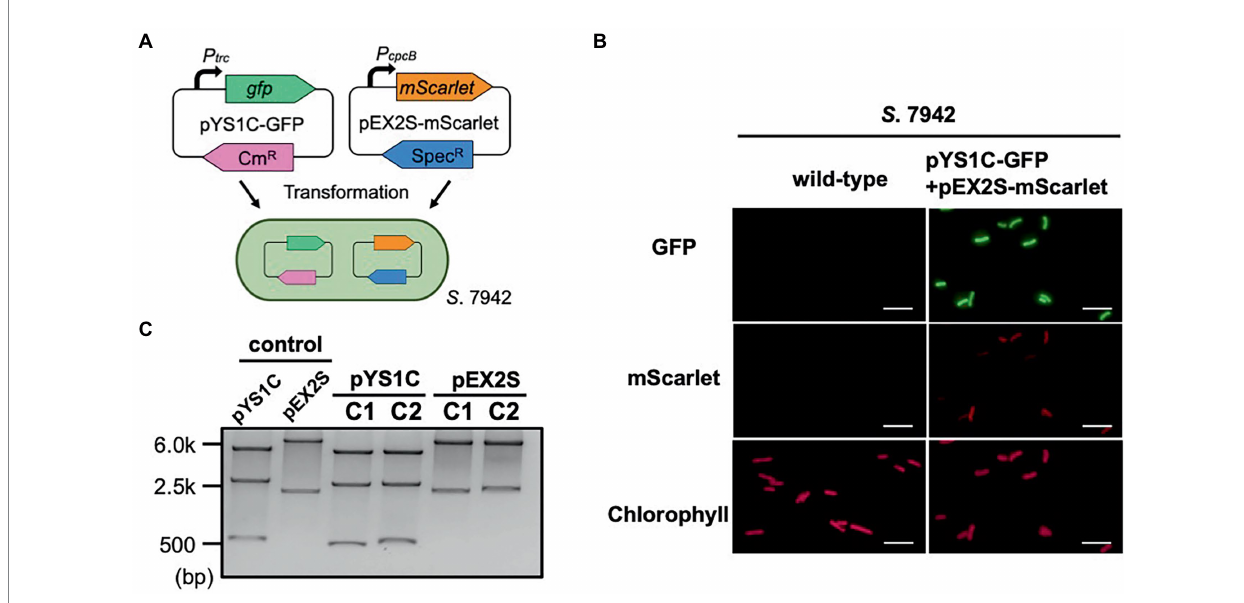
FIGURE 4 Compatibility of pYS and endogenous plasmid-derived vectors in S . 7942. (A) Compatibility test in S . 7942. pEX2S-mScarlet containing spectinomycin resistance gene ( Sp R ) with pHU24/pANS Rep was introduced into S . 7942 cell carrying pYS1C-GFP and subjected to microscopy and DNA extraction. (B) Fluorescence microscopy. GFP expression was induced in pYS1C-GFP by the addition of 1 mM IPTG (final concentration) to the culture. Images of GFP, mScarlet, and chlorophyll fluorescence are shown. White bar: 10 μ m. (C) Structure of the plasmids before and after the transformation of S .